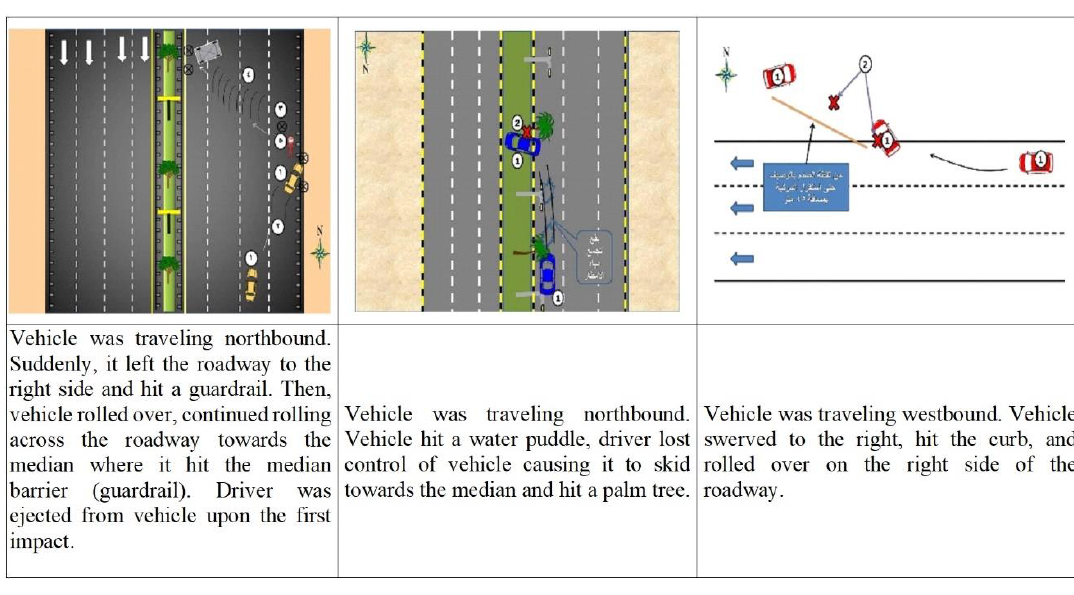
Figure 1. Crash Descriptions and Diagrams.